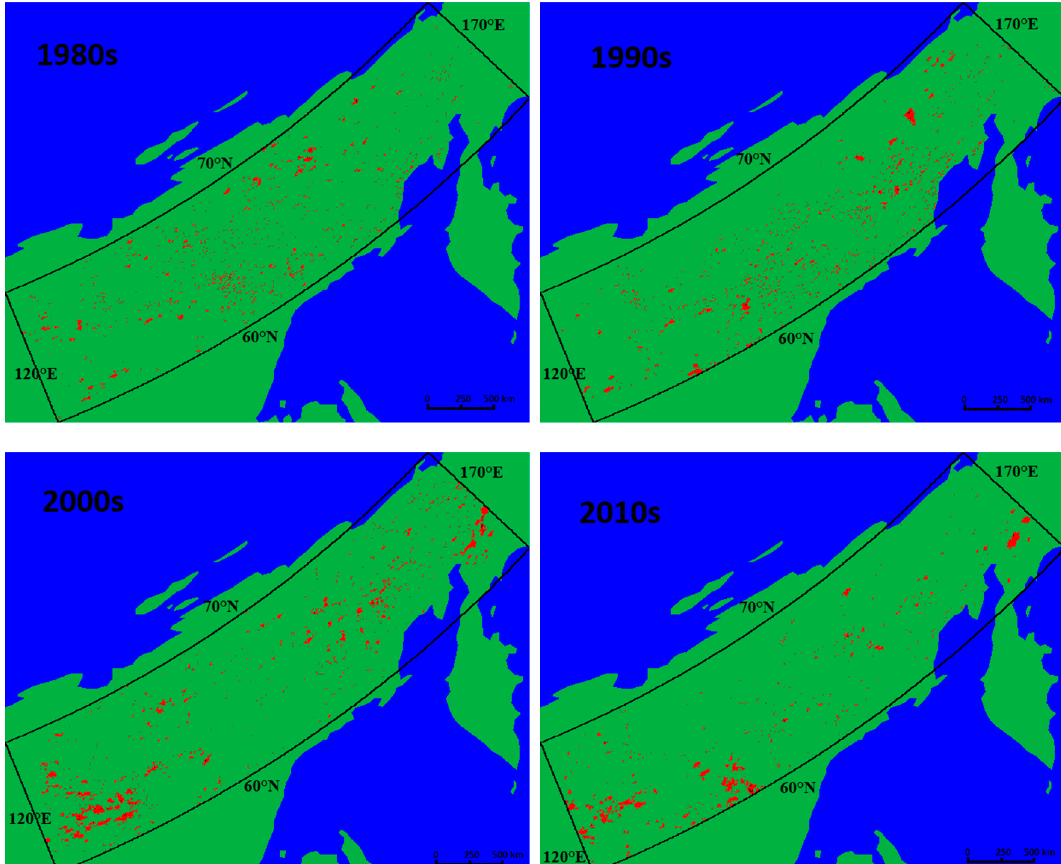
Figure 3. BA (red) differentiated from nonburned (green) and water bodies (blue) for the Northeastern Siberian boreal region for the 1982–2015 period grouped by decade.